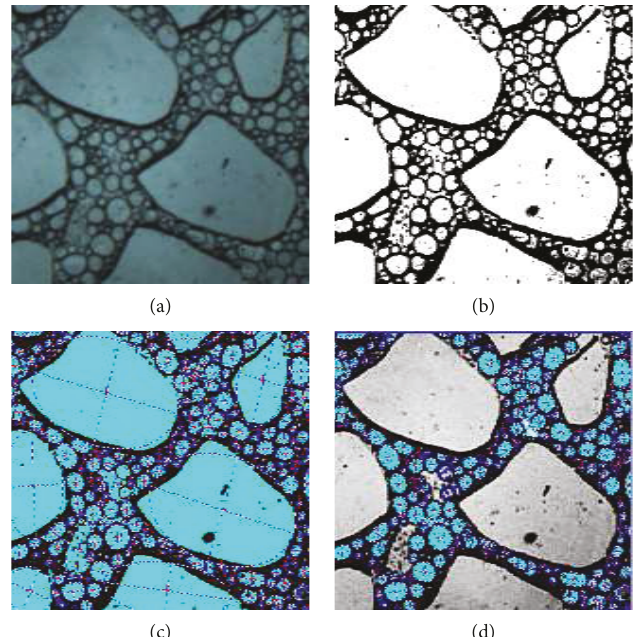
Figure 3: Foam images before and after processing. (a) is the original image observed directly. (b) is the image after binarization. (c) is the image after segmentation. (d) is the image after